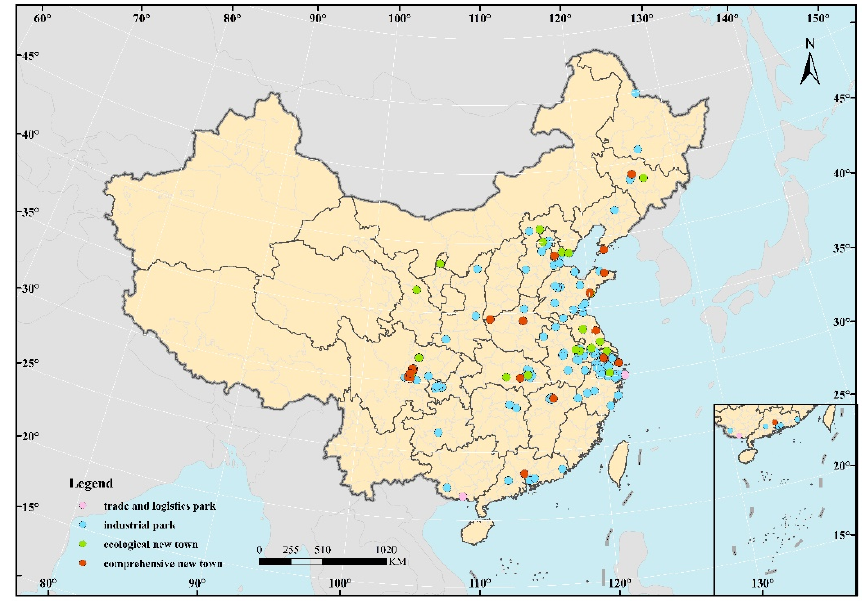
Figure 4. The types of DICPs.